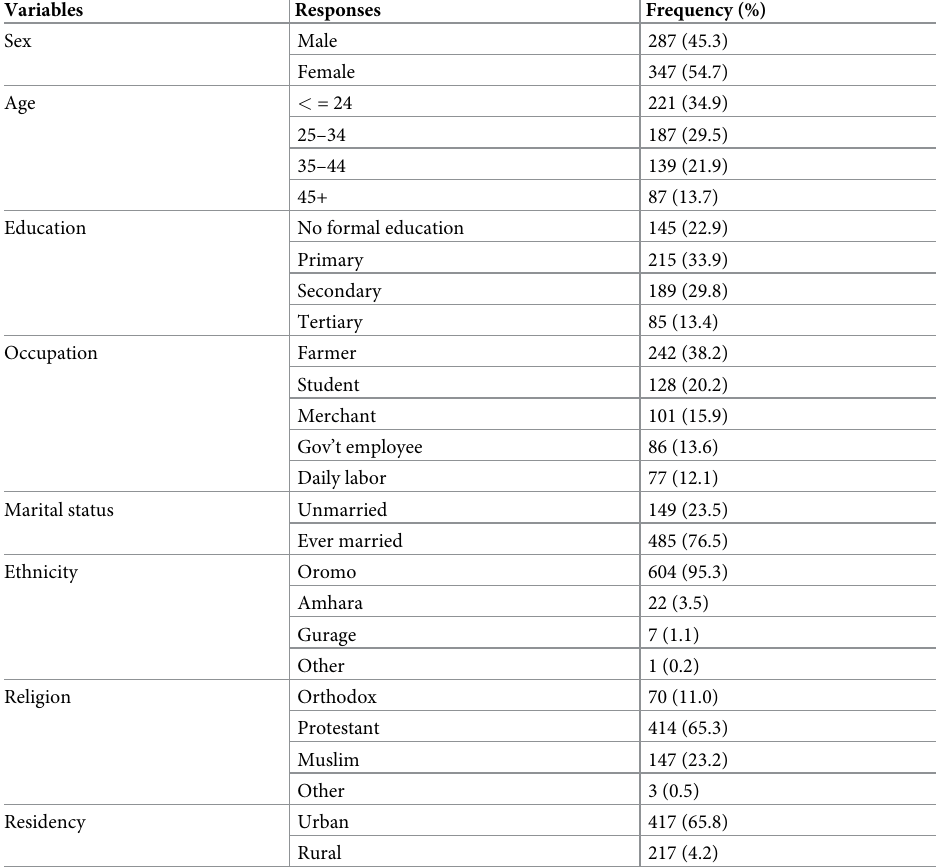
Table 1. Socio-demographic characteristic of the study participants on assessment of preventive behavior and associated factors for covid-19 in Qellam Wallaga Zone, Oromia, Ethiopia,